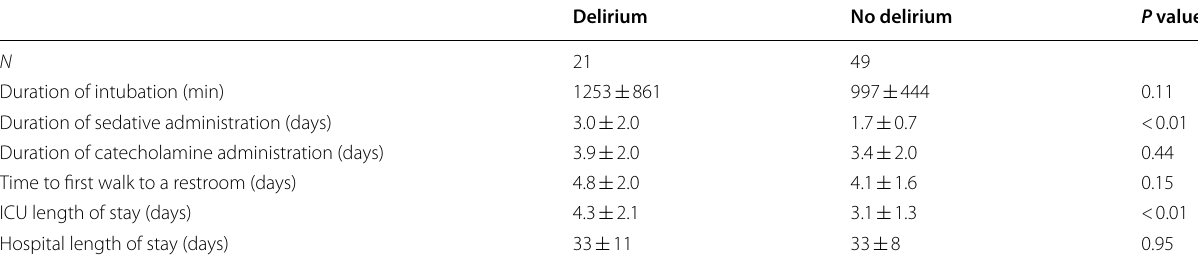
Data are expressed as mean